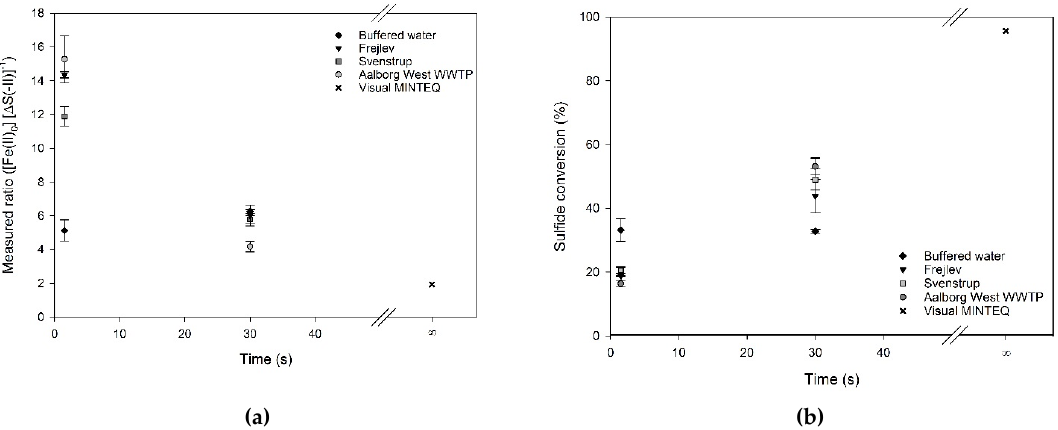
Figure 4. ( a ) The stoichiometric ratio of sulfide precipitation by ferrous iron in different waters at pH 7 (average of three individual measurements and their standard deviation). ( b ) Sulfide conversion of the same samples. The value at t = ∞ is a simulation of equilibrium conditions applying Visual MINTEQ.